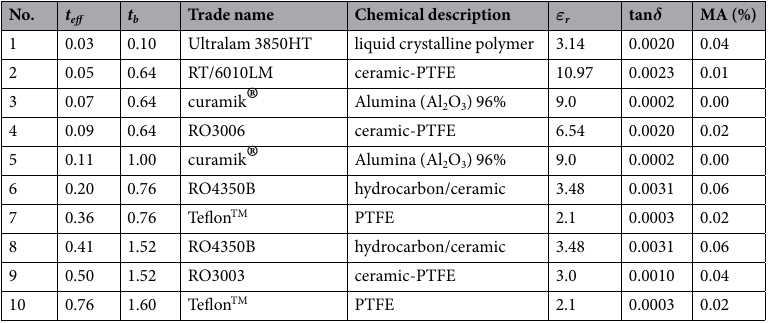
Table 1. Main properties of the materials used as dielectric barrier in the DBD plasma reactor. t eff = dielectric effective thickness in millimeters; t b = physical thickness of the dielectric barrier in millimeters; ε r = relative permittivity of the material; tan δ = loss tangent or dissipation factor; MA = moisture absorption; PTFE =